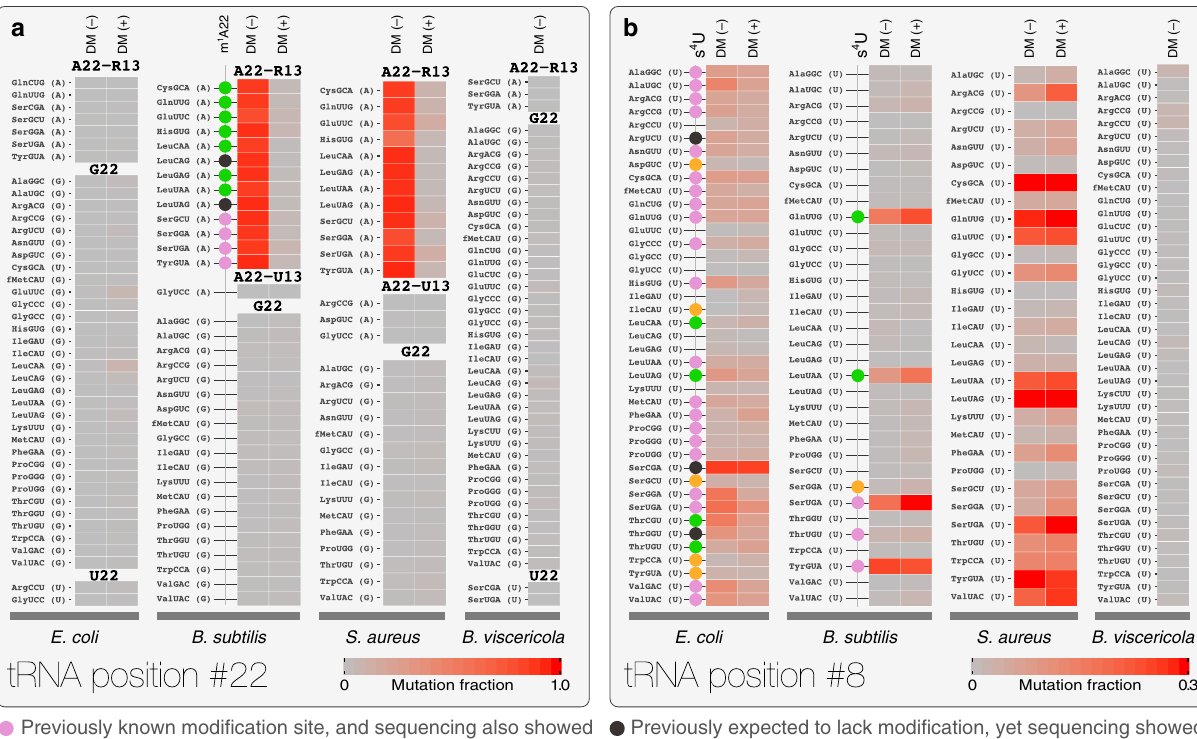
Fig. 2 Mutation fractions of two tRNA sites. Heatmaps of mutation fractions for positions 22 and 8 (using standard, canonical tRNA nomenclature) are shown. tRNAs with different anticodons are grouped by their sequences at the respective position of modi fi cation (in parenthesis) and in alphabetical orders. Only E. coli and B. subtilis tRNA modi fi cations have been mapped previously by 2D-TLC and LC/MS, but the mapping was not done for every tRNA species 12 . Every E. coli and B. subtilis tRNA species with mutation fraction at10-times above background is marked with a circle on the right with the following designations: Purples correspond to those known to be present and also identi fi ed by sequencing here; blacks correspond to those supposed to be absent but identi fi ed by sequencing; greens correspond to those not mapped previously but identi fi ed by sequencing; oranges correspond to those known to be present but were not found by sequencing. a m 1 A22; R corresponds to A or G. b s 4